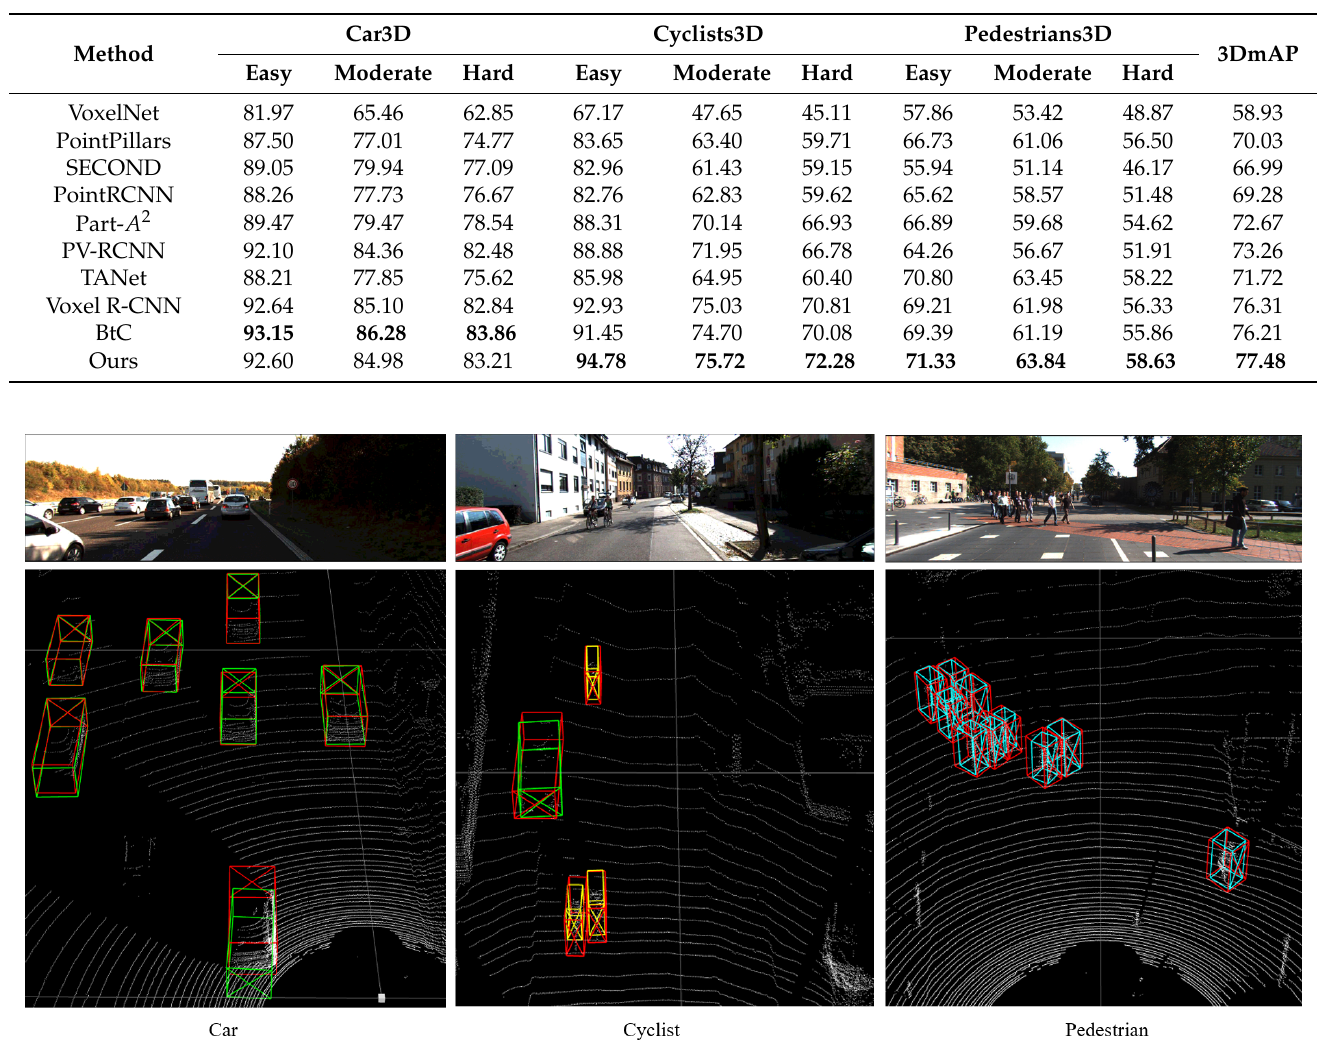
Table 2. 3D object detection performance: average precision (AP) (in %) and mean average precision (mAP) (in %) for 3D object boxes in the KITTI validation set.